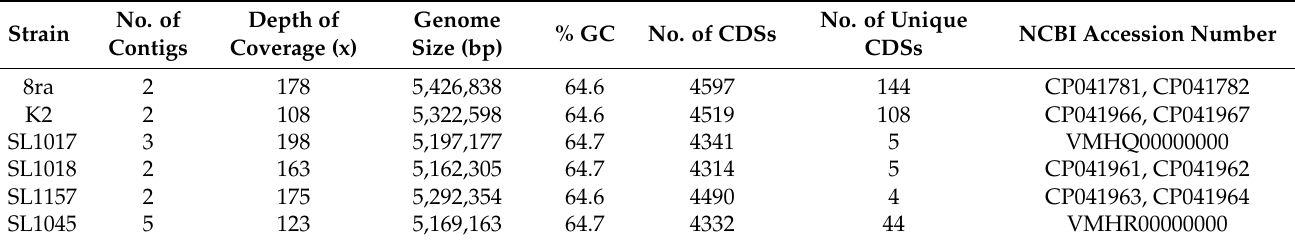
Table 1. General genomic features of six X. citri pv. glycines